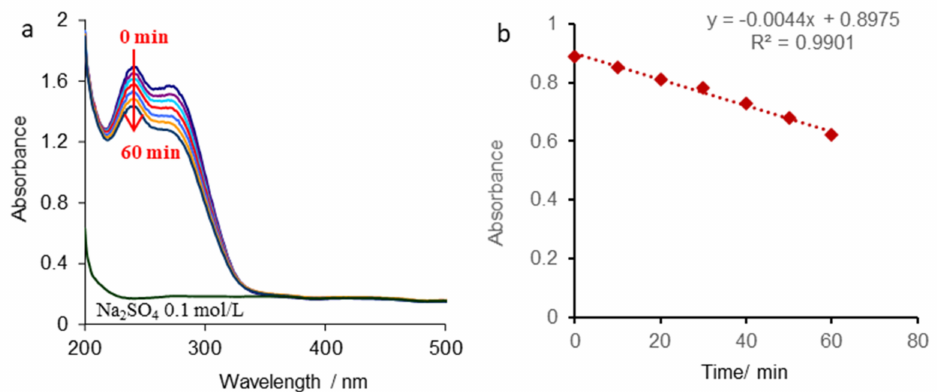
Figure 5. UV-Vis spectra of CFTX in 0.1 mol L − 1 Na 2 SO 4 solution obtained during electrolysis at constant current density of 50 mA cm − 2 ( a ) and kinetic model of CFTX degradation reaction in the presence of SO 42 − ions ( b